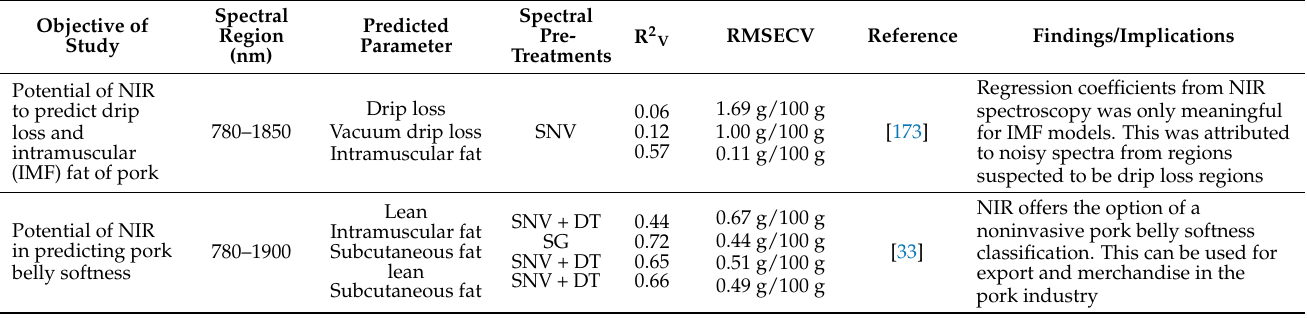
Table 4. PLSR prediction of different quality parameters in meat and fish using near infrared